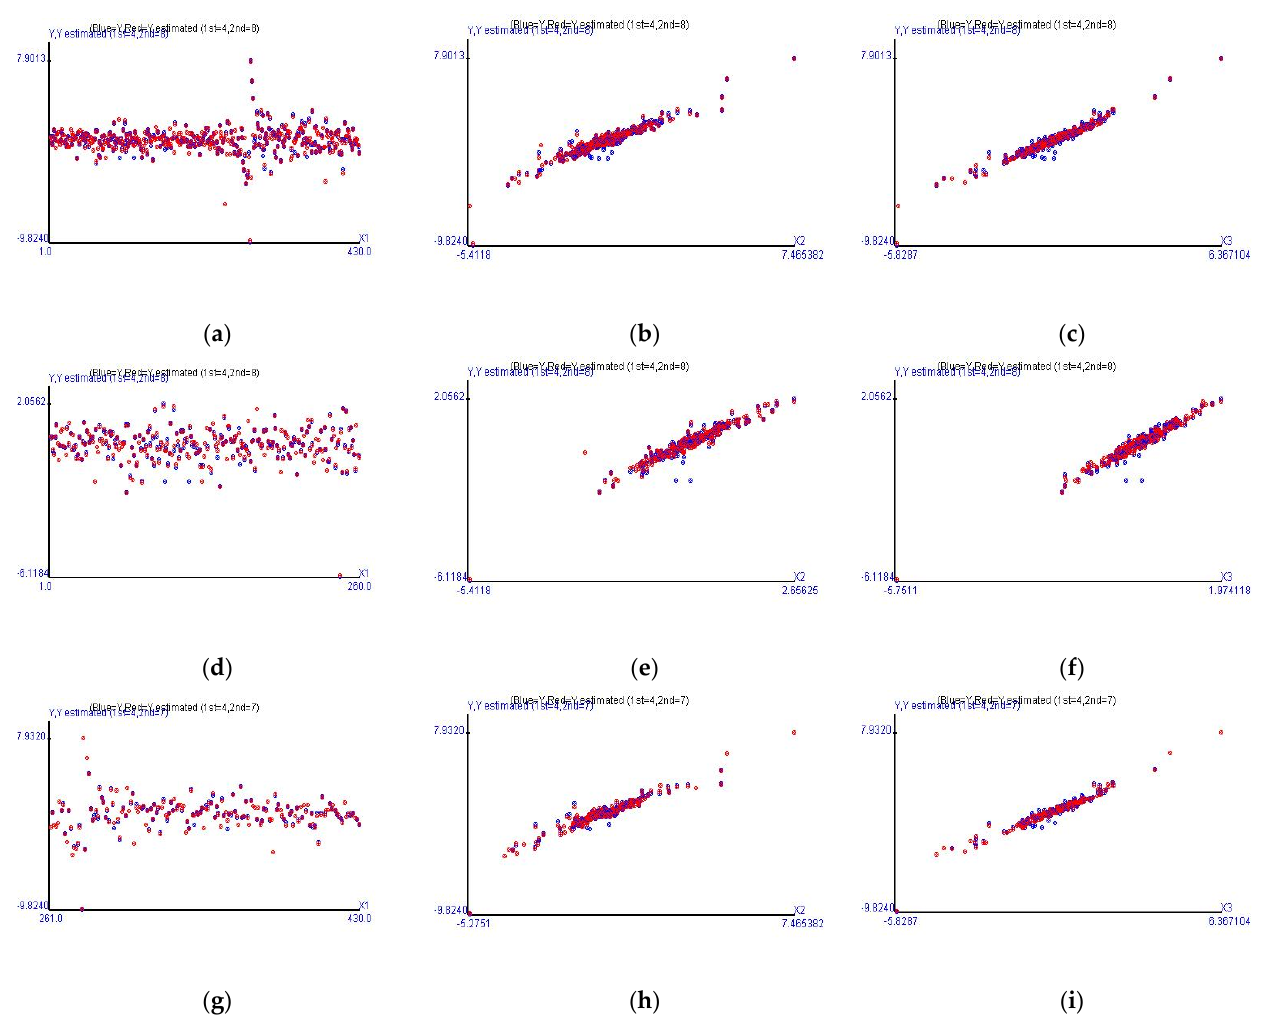
Figure 3. The actual and fitted values in different cases using the combination of the fitted models of the expected value and heteroscedasticity. ( a – c ) is Case 1; ( d – f ) is Case 2; and ( g – i ) is Case 3.